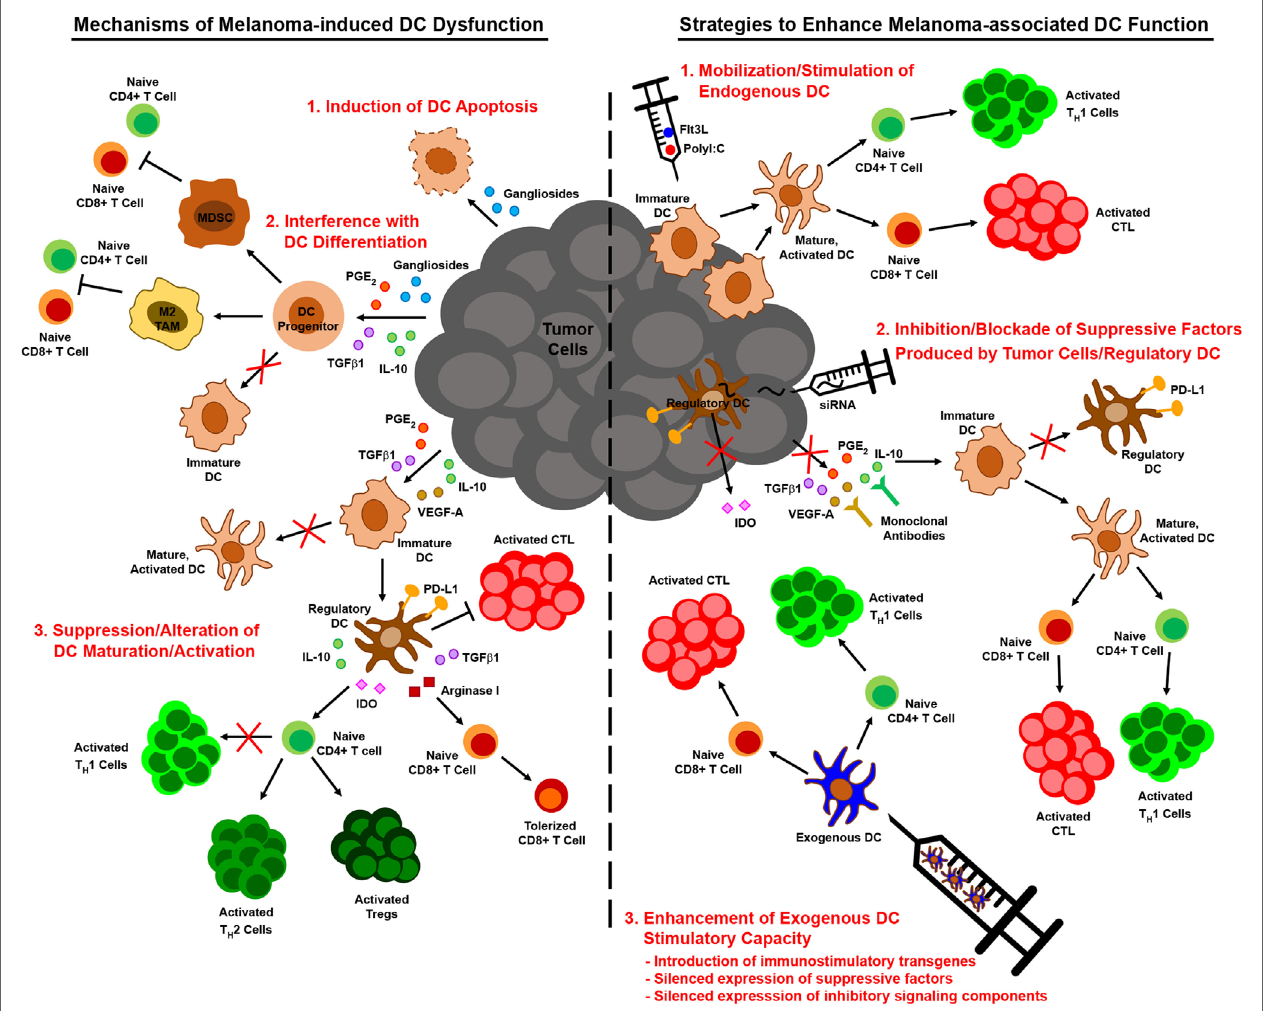
FiGURe 2 | Melanoma-associated dendritic cell (DC) dysfunction and therapeutic interventions to enhance DC-mediated anti-melanoma immune responses. Melanoma interferes with the function of DC by numerous mechanisms, including induction of DC apoptosis, blocking/altering DC development from hematopoietic precursors, suppressing DC maturation/activation, and driving the differentiation of tumor-promoting regulatory DC (left). Insights into these mechanisms of melanoma-altered DC dysfunction have informed strategies to augment DC-mediated anti-melanoma immune responses. These strategies include approaches that mobilize and stimulate endogenous DC, interventions that impede the production or action of immunosuppressive factors released by melanoma and associated cells in the tumor microenvironment, and regimens that employ exogenous DC that have been manipulated to resist suppressive elements and stimulate robust antitumor immunity